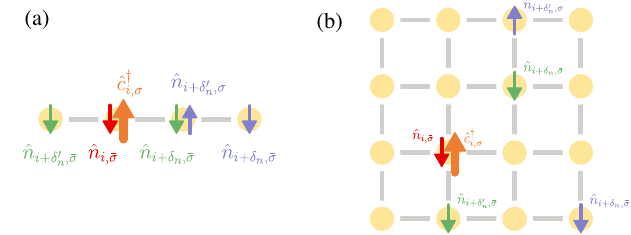
FIG. 1. Geometries of the system studied in this paper. (a) One- dimensional lattice. (b) Two-dimensional square lattice. The excitation on site i is correlated with the presence of electrons on neighboring sites. The charge of the excitation of type ˆ c † ˆ n Ω i is represented by the red arrow. The charges of the i ¯ σ j i σ ˆ n ˆ n Ω i are represented by the two excitation of type ˆ c † i þ δ n ; ¯ σ i þ δ 0 n ; σ j i σ blue arrows, and the charges of the excitation of type ˆ n ˆ n ˆ c † Ω i are represented by the two green arrows. i þ δ n ; ¯ σ i þ δ 0 n ; σ j i σ Here, δ and δ 0 denote only the difference in position relative to n n the site i , only for the excitation illustrated here. If we consider the excitation n þ 1 , for example, the values δ and δ 0 would be n n different, leading to another “ arrow couple ” (for green and blue “ arrow couples ” ). We only show one example of such excitation per excitation type, for